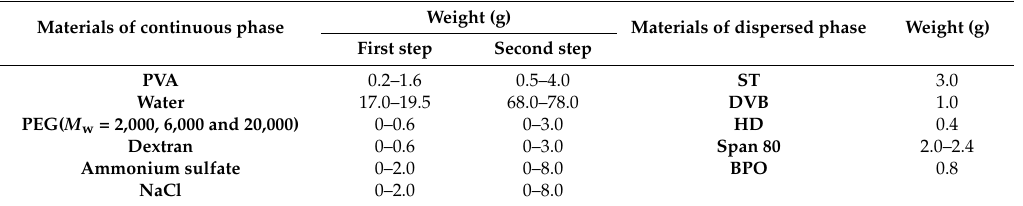
Table 1. The recipe for microspheres